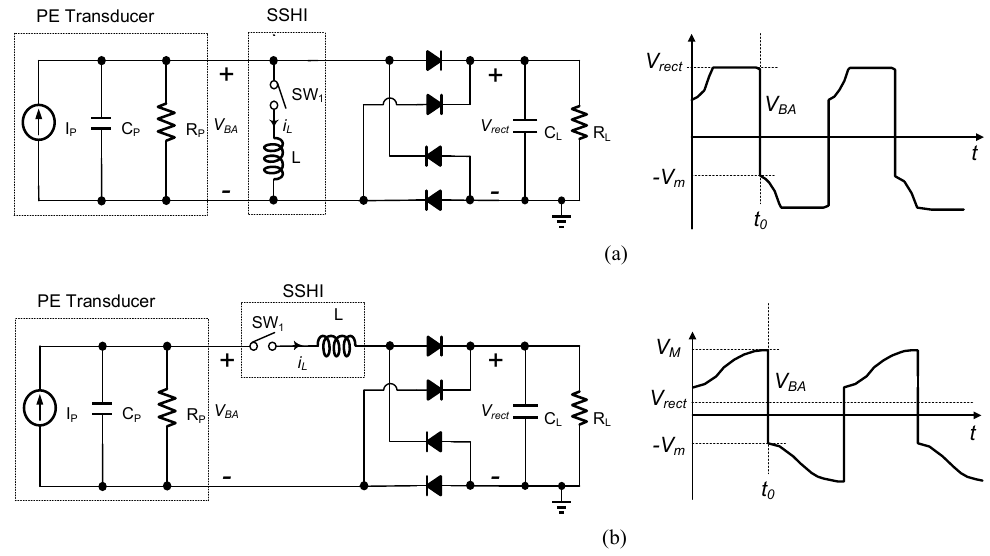
Figure 2. Typical ( a ) P-SSHI circuit and ( b ) S-SSHI circuit.